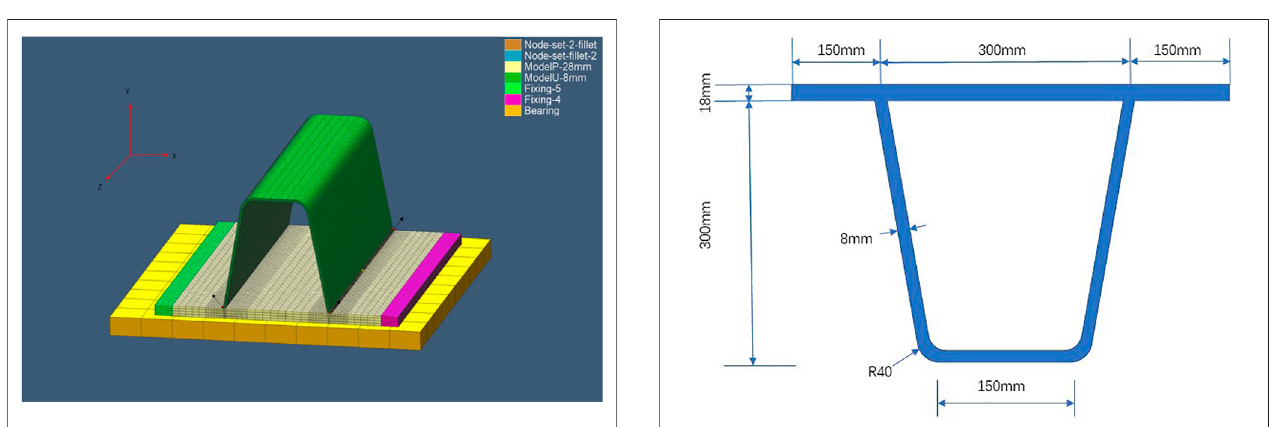
Figure 2 details the cross-section of the U-rib stiffened plates.